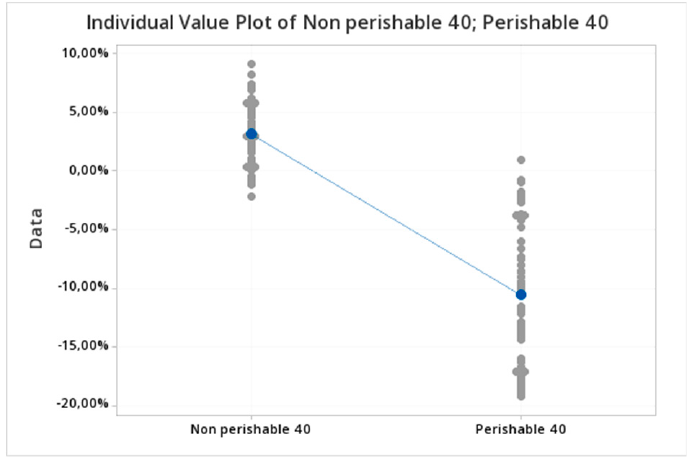
Figure 14. Boxplot CAARs event window E ( − 20, + 20).